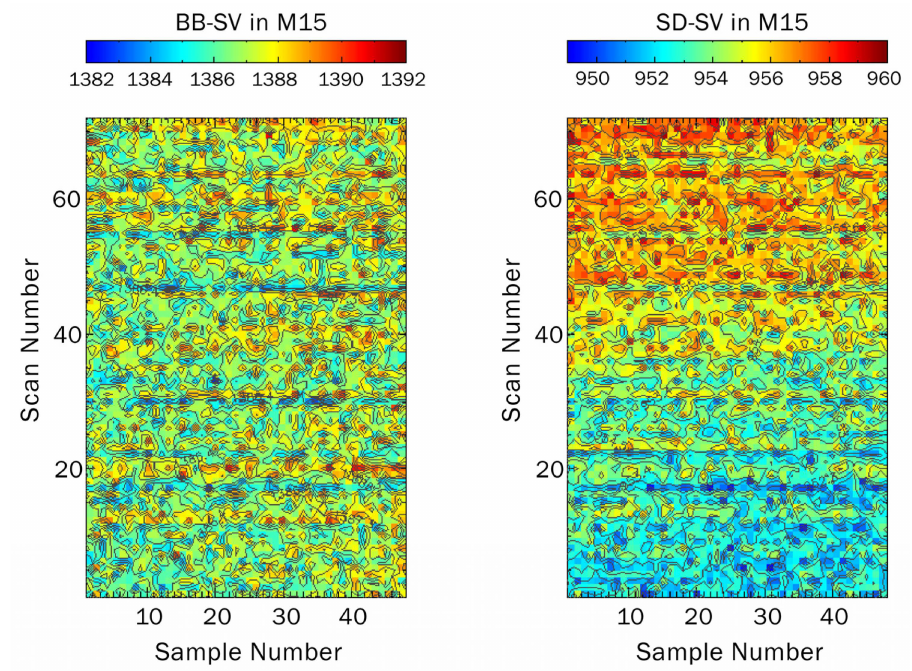
Figure 10. The distribution of BB ´ SV ( i.e. , dBB; left ) and SD ´ SV ( i.e. , dSD; right ) for detector 1 in M15. Color represents the value of data.